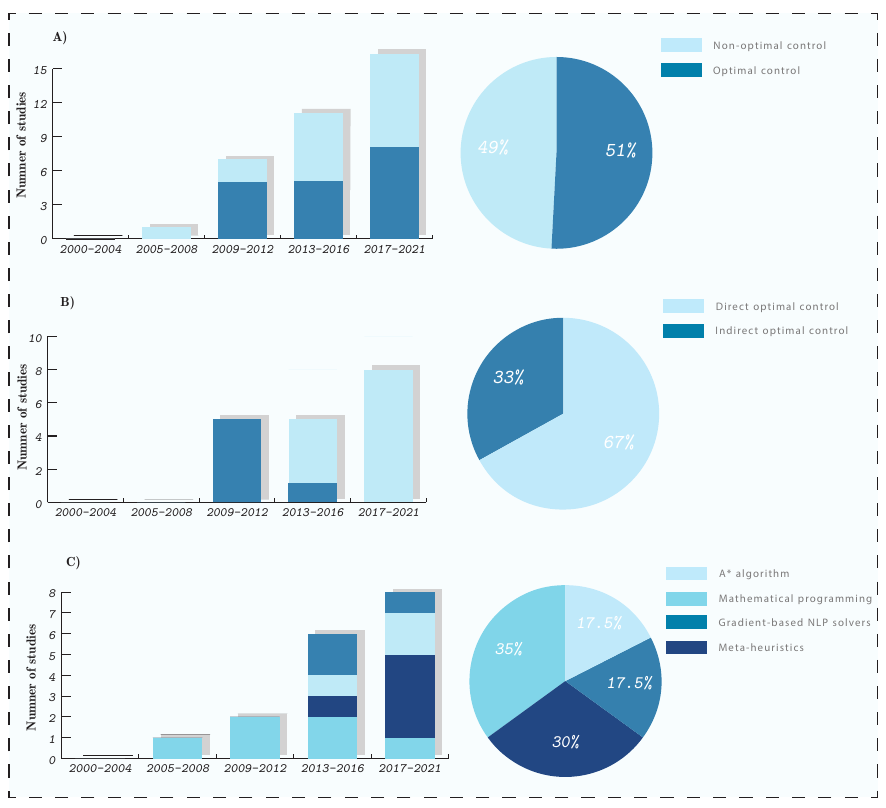
Figure 5. Overview of investigated optimization-based strategies for mitigating climate impacts of